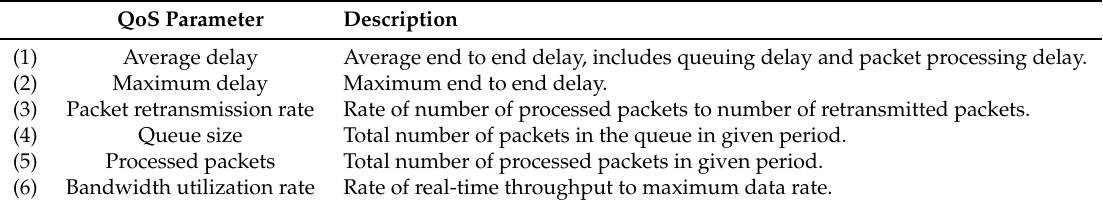
Table 3. QoS evaluation parameters in queuing